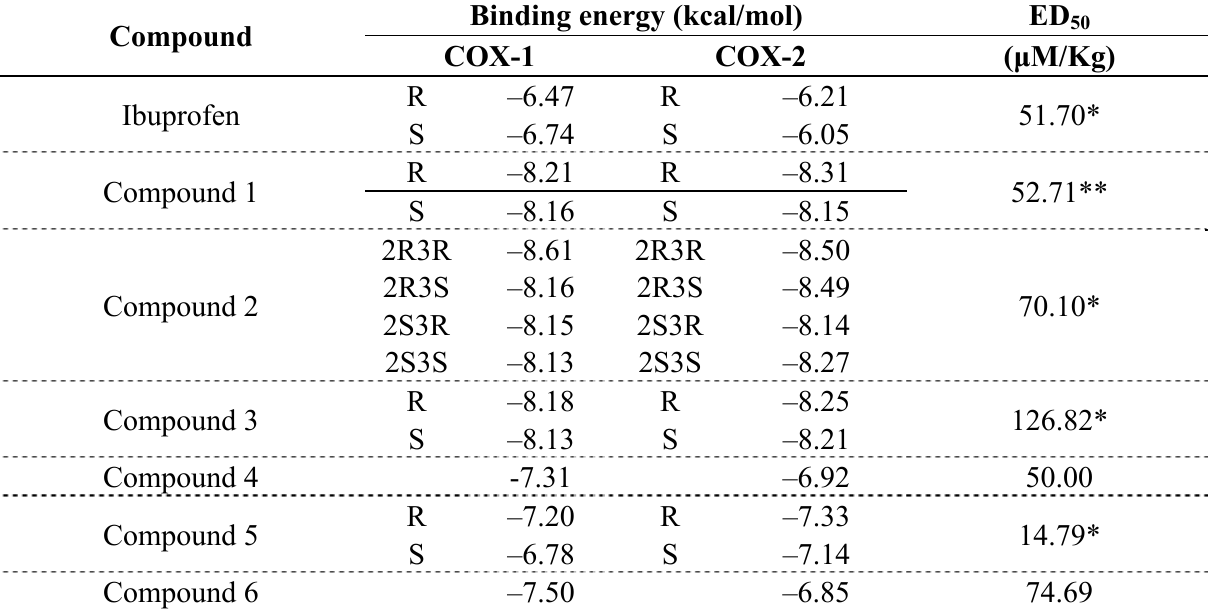
Table 1. Binding energies of top scored solutions as resulting from docking experiments, and corresponding standard biological response of studied